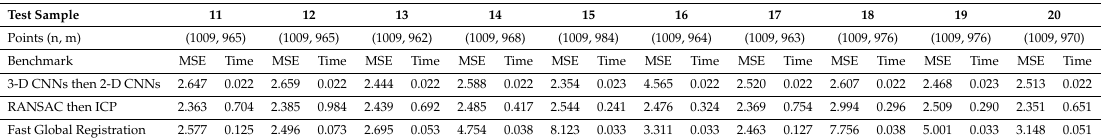
Table 4. The comparisons about MSE and computation time of “Horse” data for test samples from 11 to 20.